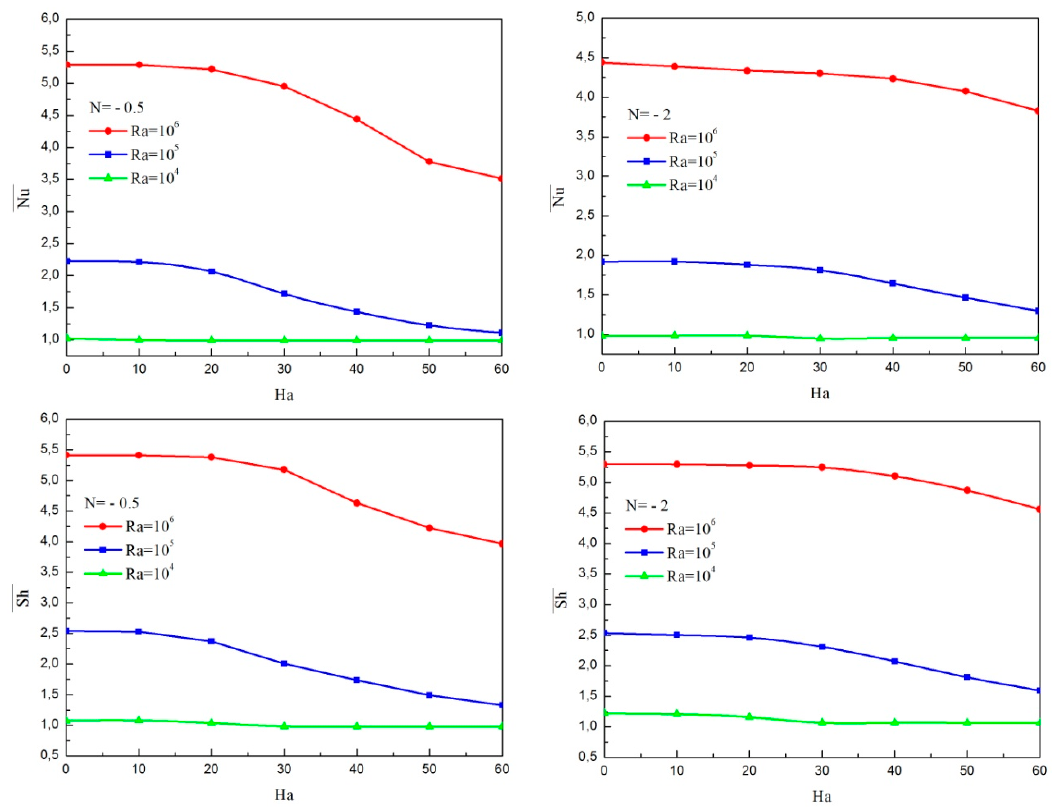
Figure 15. Variations of both Nu and Sh according to Hartmann number for different Rayleigh numbers with φ = 4%, K = 1, N = − 0.5 and N = − 2 for Pr = 6.2 and Le = 1.